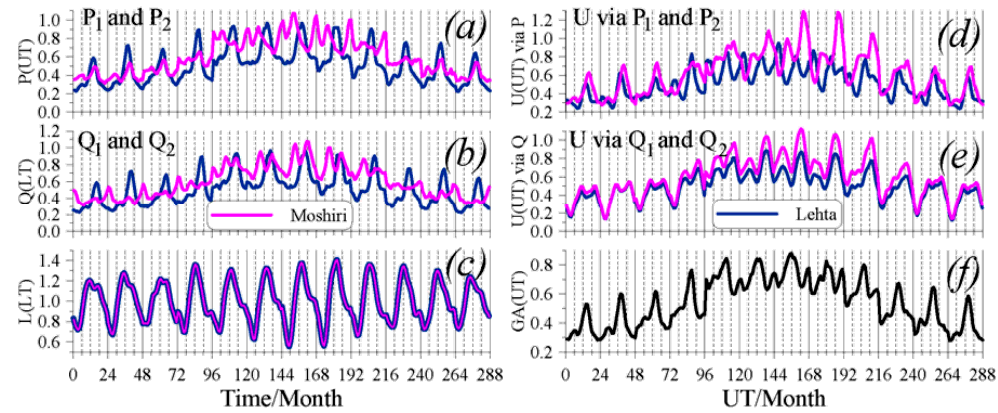
Fig. 7. Survey of experimental data from Lehta and Moshiri and of the local and universal modulations